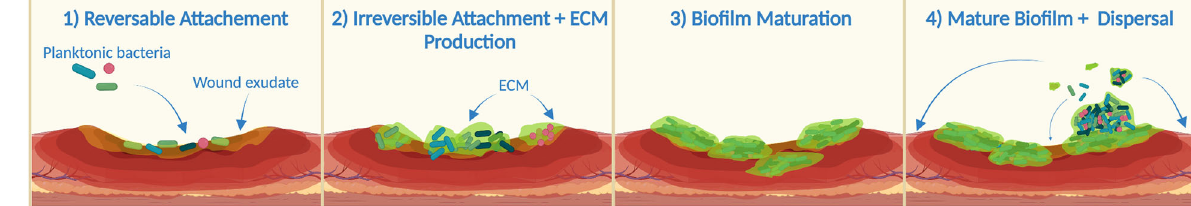
Fig. 1 The proposed stages of bio fi lm bacterial infection development in the burn wound. (1) Burn wounds typically contain BWE which facilitates the initial inoculation and reversible attachment by planktonic pathogens. (2) Bacteria begin to produce ECM and form microcolonies during the process of irreversible attachment (3) During the maturation stage, the bio fi lm grows in size and structural complexity. (4) The mature bio fi lm enters the dispersal stage, releasing the planktonic cells from the ECM which can then colonize new sites within the wound. Created with